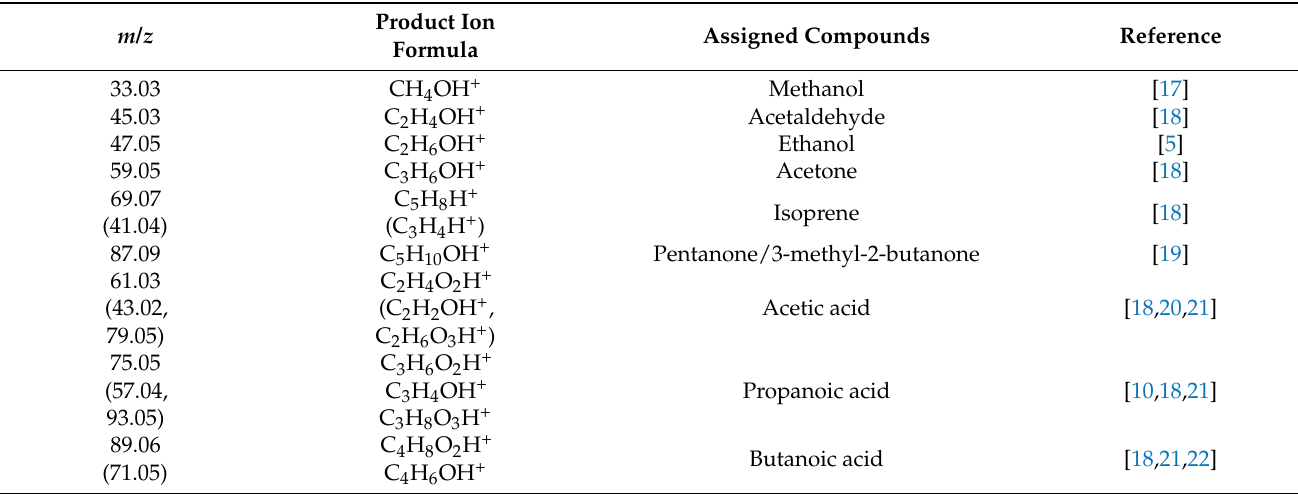
Table 1. Endogenous compounds related to the differences in the response to exercise and/or the statin use. The m/z values given in parentheses indicate product ion fragments or hydrate clusters.